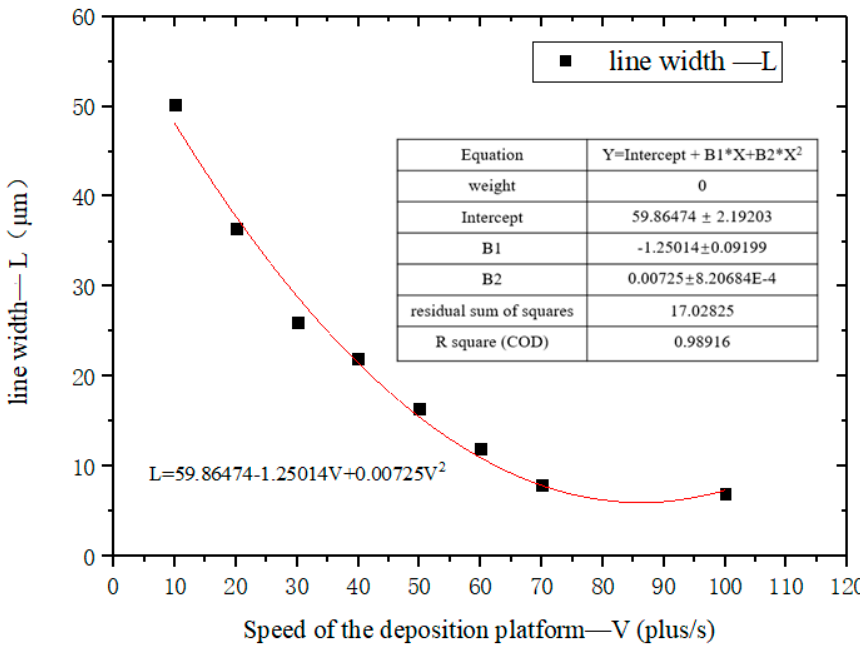
Figure 11. Conic relationship between line width and the velocity of deposition platform. Table 2. The measurement data of depositing line.